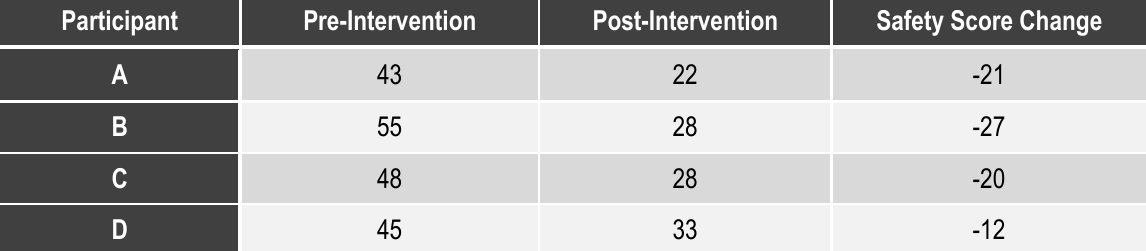
Table 3. Participant Change in SAFER-HOME v. 3 Home Safety Score